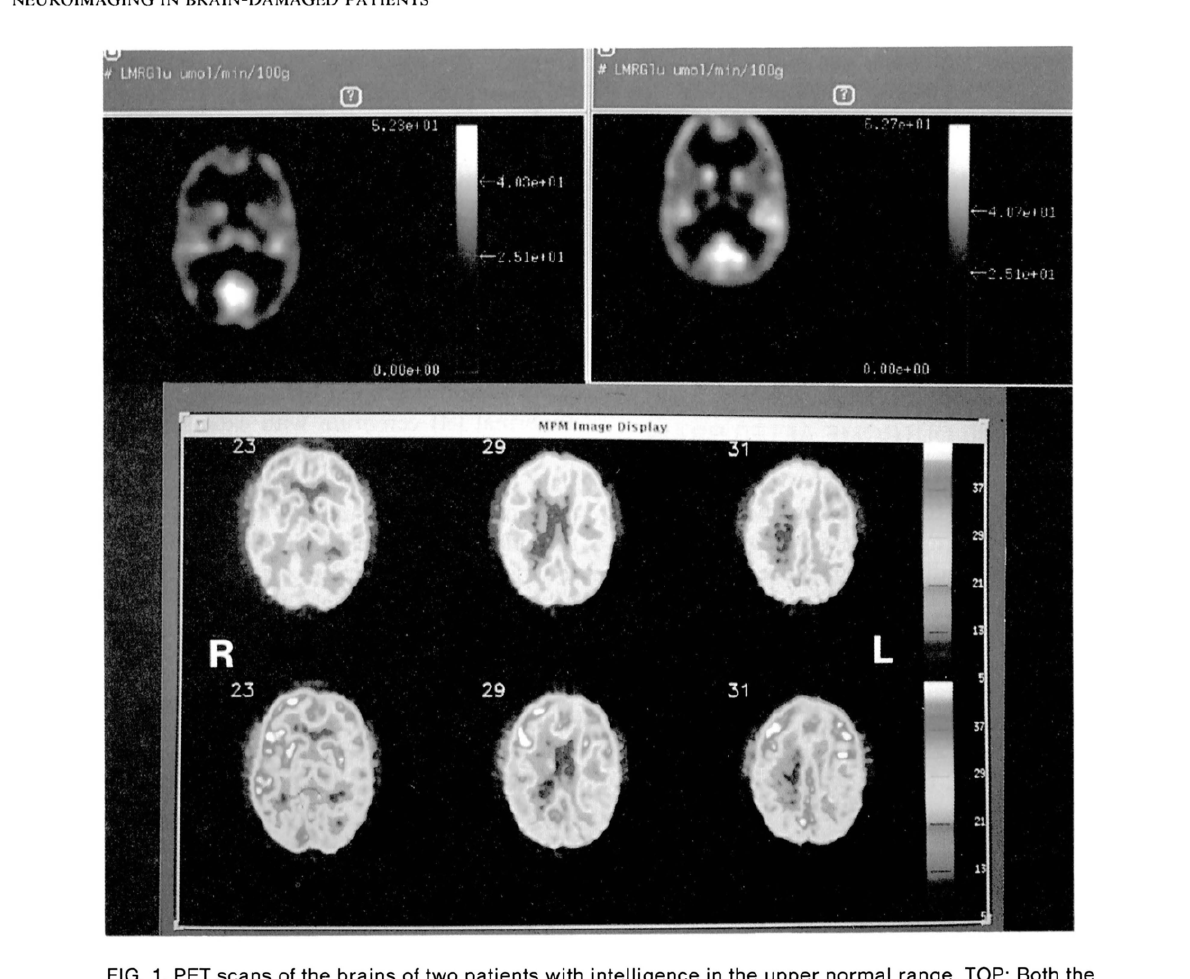
FIG. 1. PET scans of the brains of two patients with intelligence in the upper normal range. TOP: Both the left and right picture show normal cerebral glucose metabolism in a patient with no visible brain damage, but severe and long-lasting cognitive impairments. BOTTOM: PET images of glucose metabolism in a patient with left-hemispheric neuronal heterotopia. The upper row demonstrates the brain's metabolism under resting conditions and the lower row during activation. Increased glucose metabolism during activation (word generation) is seen both within areas of the normal cortex and within areas of the heterotopias. This patient (a medical student) had subtle neuropsychological deficits, and initially had been diagnosed as neurologically inconspicuous (see description in Calabrese et al.,